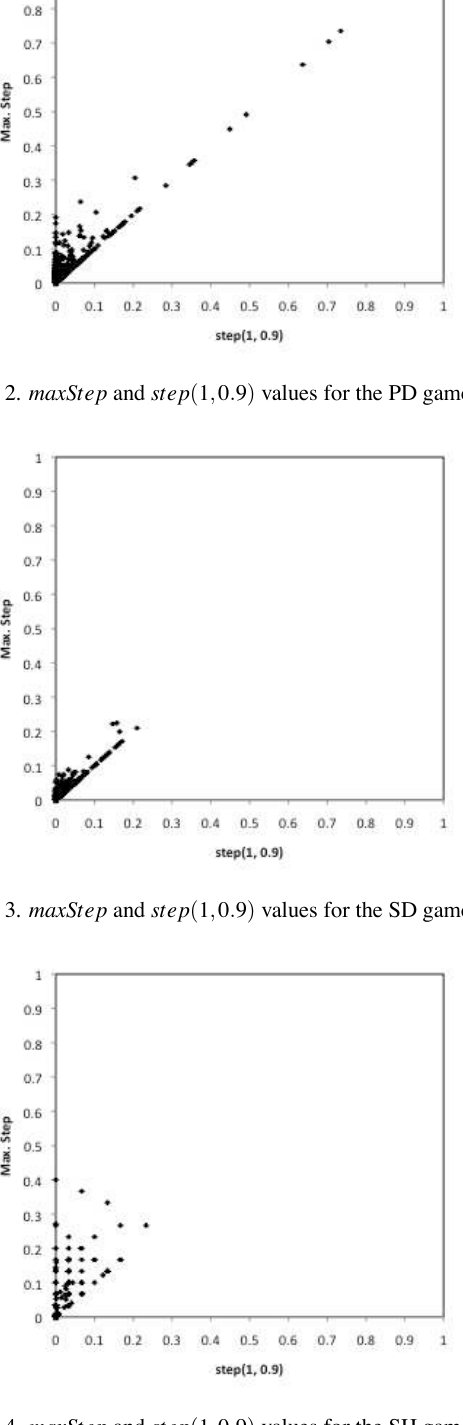
Fig. 4. maxStep and step ( 1 , 0 . 9 ) values for the SH game.